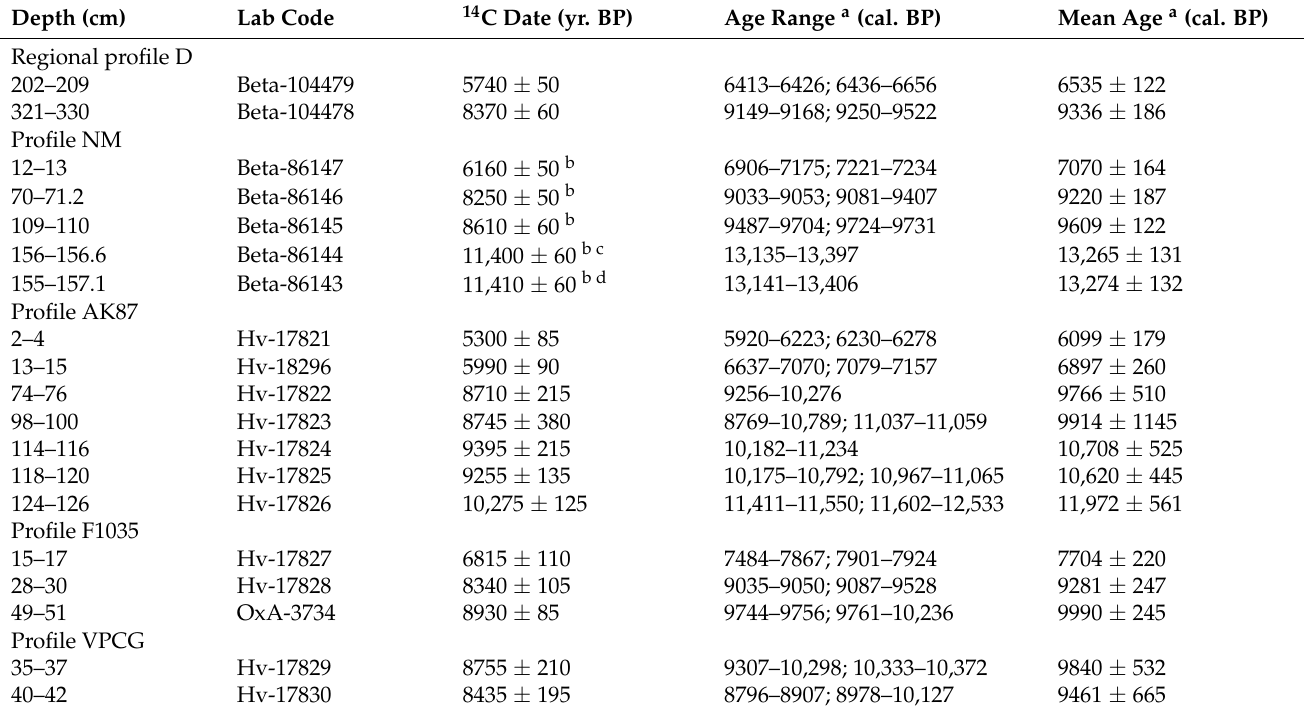
Table 2. Results of radiocarbon dating, on bulk peat unless stated, and radiometric unless shown as